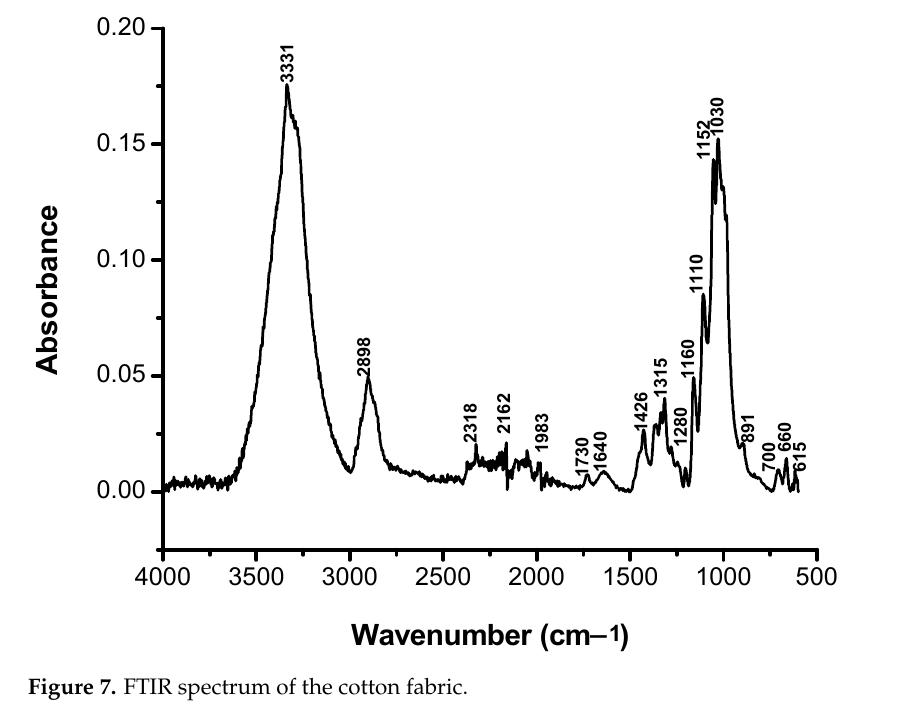
Figure 7. FTIR spectrum of the cotton fabric. Figure 7 . FTIR spectrum of the cotton fabric.